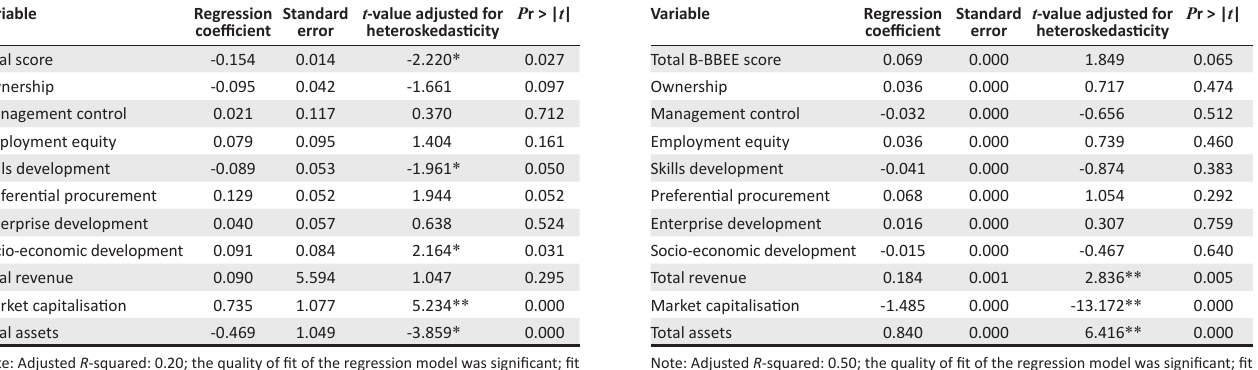
TABLE 9: Default risk probability and total Broad-Based Black Economic Empowerment score and individual elements.